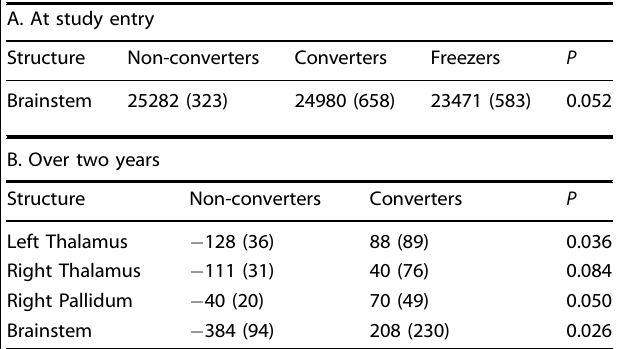
Fig. 3 Prediction of conversion to FOG over two years. Area under the curve of the FOG conversion model including sex, daily levodopa equivalent dose, and left thalamus local volume is shown. The area under the curve of the model was 0.87 and the Brier score was 0.11. Optimum performance was achieved at two Youden ’ s points (in orange), probability cutoffs of 0.09 (sensitivity: 100%, speci fi city: 66.7%) and 0.19 (sensitivity: 88.9%, speci fi city: 77.8%). Box and whisker plots of predicted probabilities are also shown for non-converters and converters along with median (horizontal line) and mean (x), showing good separation of the two groups (inset).